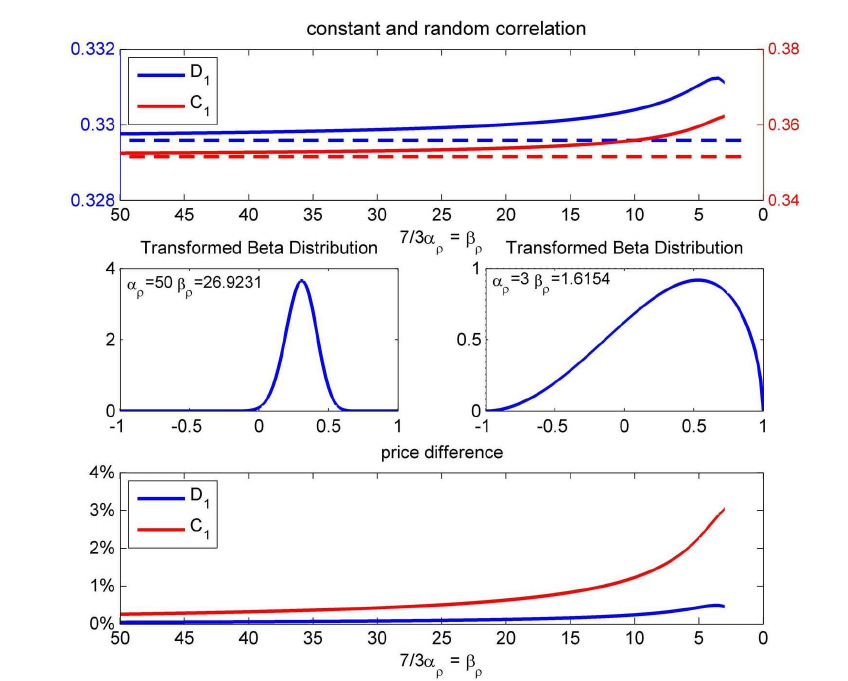
Figure 8. Effect of increasing uncertainty about ˜ ρ and price differences between random and constant correlation.